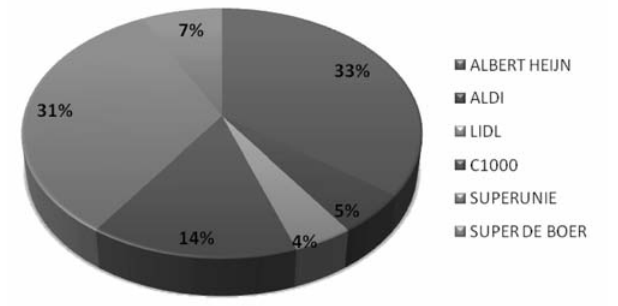
Figure 5. Supermarket sales of frozen vegetables (value) Source: PT / Nielsen